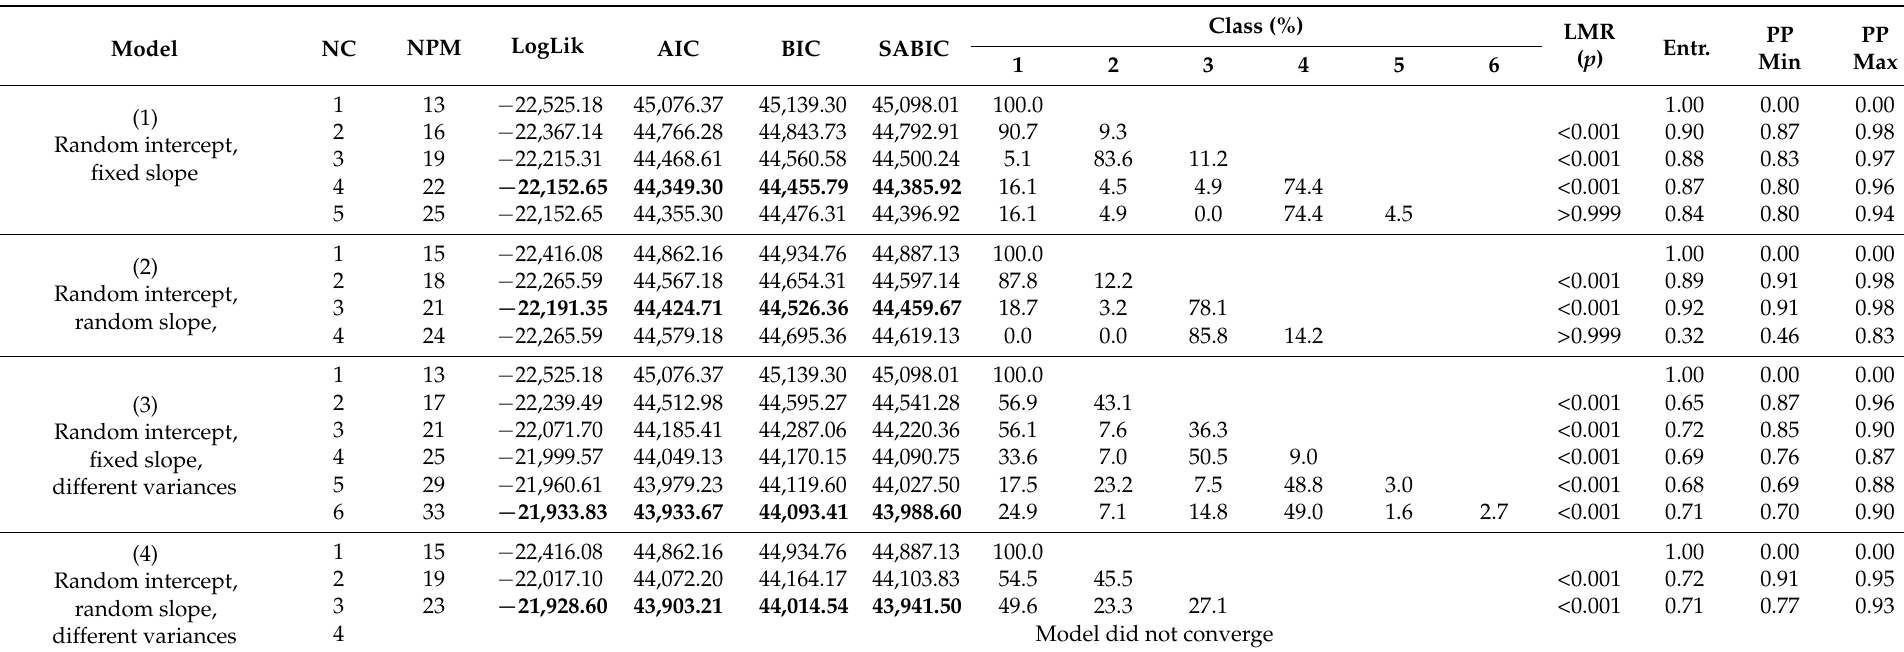
Table A8. Multivariate Latent Class Growth Analysis for PHQ-9, GAD-7, PCL-5 and RPQ for participants with uncomplicated mild TBI (N =